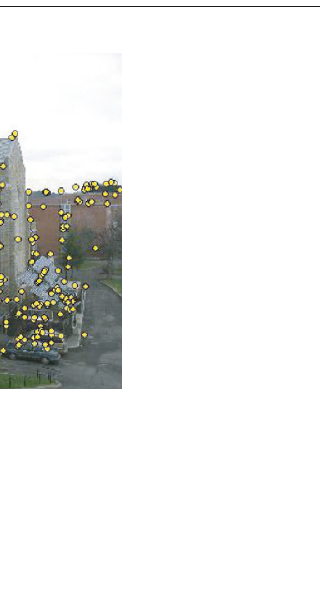
Figure 8: Camera calibration results for a prominent building in the scene. (a) Original image 2, with detected feature points overlaid. (b) The 3D reconstruction of the corresponding scene points and several cameras obtained by the distributed calibration algorithm, seen from an overhead view, with building shape manually overlaid. Parallel and perpendicular building faces can be seen to be correct. Focal lengths have been exaggerated to show camera viewing angles. This is only a subset of the entire calibrated camera